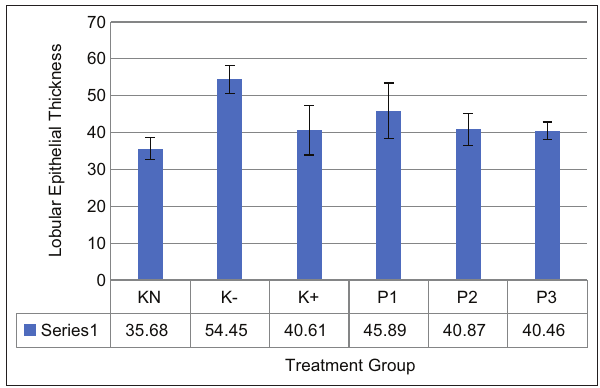
Figure-5: Effect of the ethanolic extract of red okra pods on the lobular epithelial thickness. KN=Normal control, K−=Negative control, K+=Positive control. P1, P2, and P3=Administrated with 50, 100, and 200 mg/kg body weight body weight ethanolic extract of red okra pods. Each bar represents means±standard deviation (n=5). *p<0.05 compared to the negative